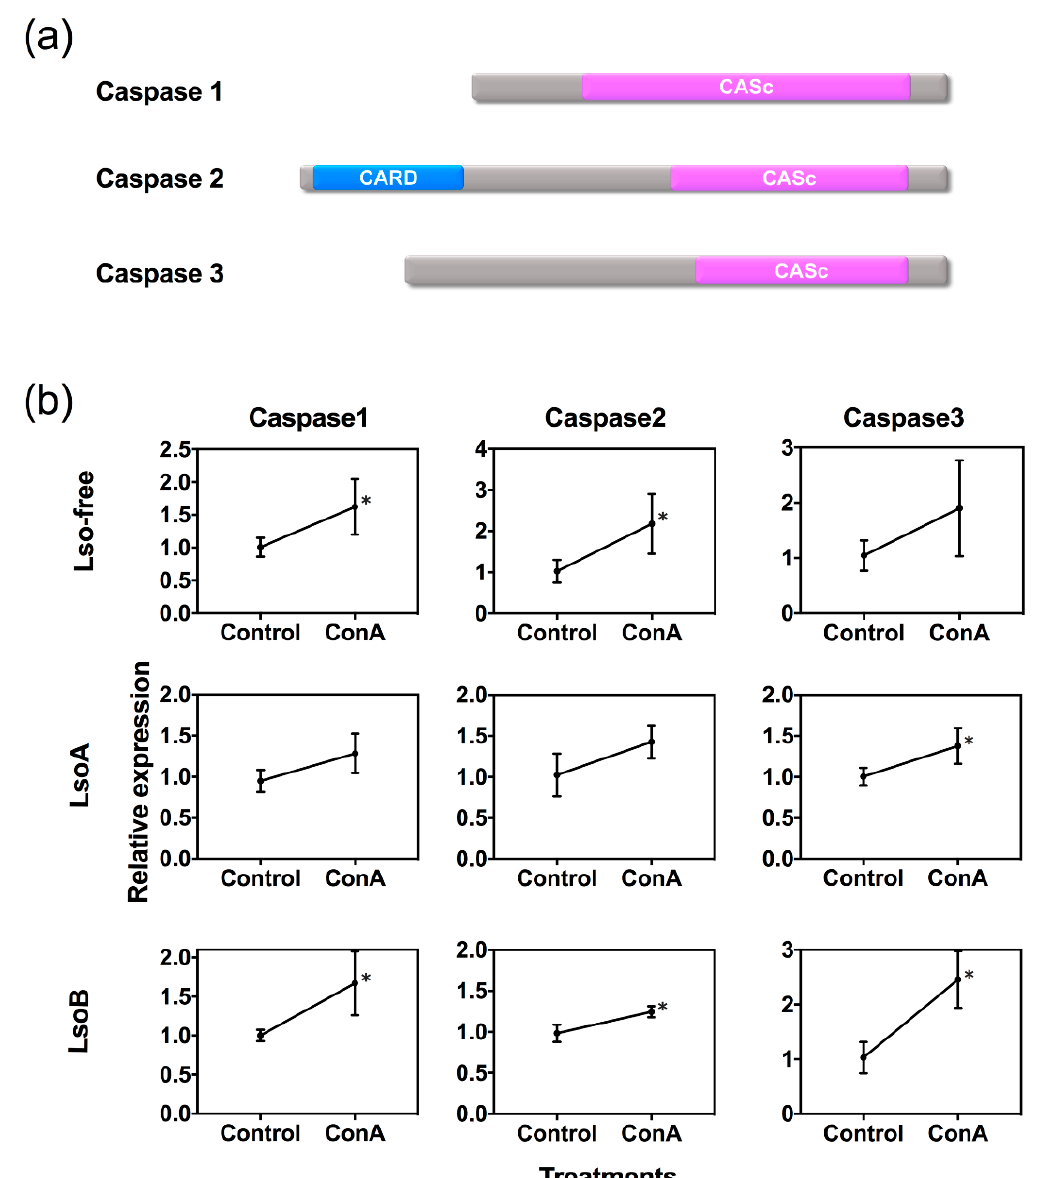
Figure 4. Gene structure and expression profiles of caspases. ( a ) Gene structure of the three caspases. CARD indicated caspase recruitment domain. CASc domain comprised of a large and a small subunit. ( b ) Significant upregulation of caspase 1, caspase 2 and caspase 3 genes in the guts of Lso-free, LsoA- , and LsoB-infected potato psyllids after 72 h exposure to ConA. * indicates p < 0.05.